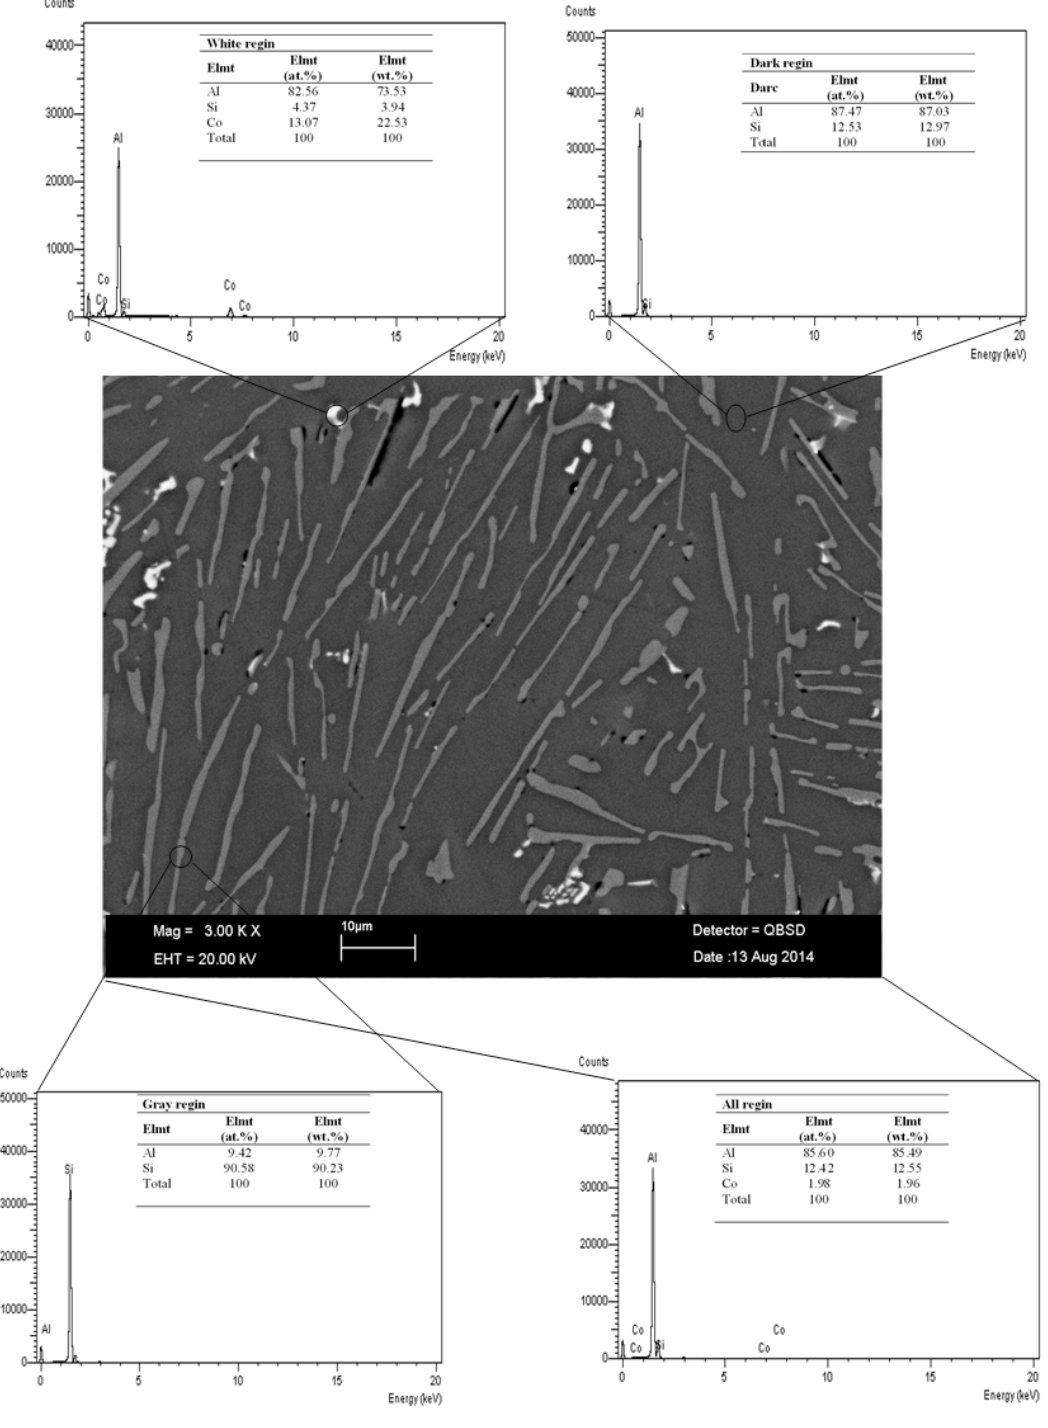
Fig 1. Analysis of the chemical composition of the alloy of